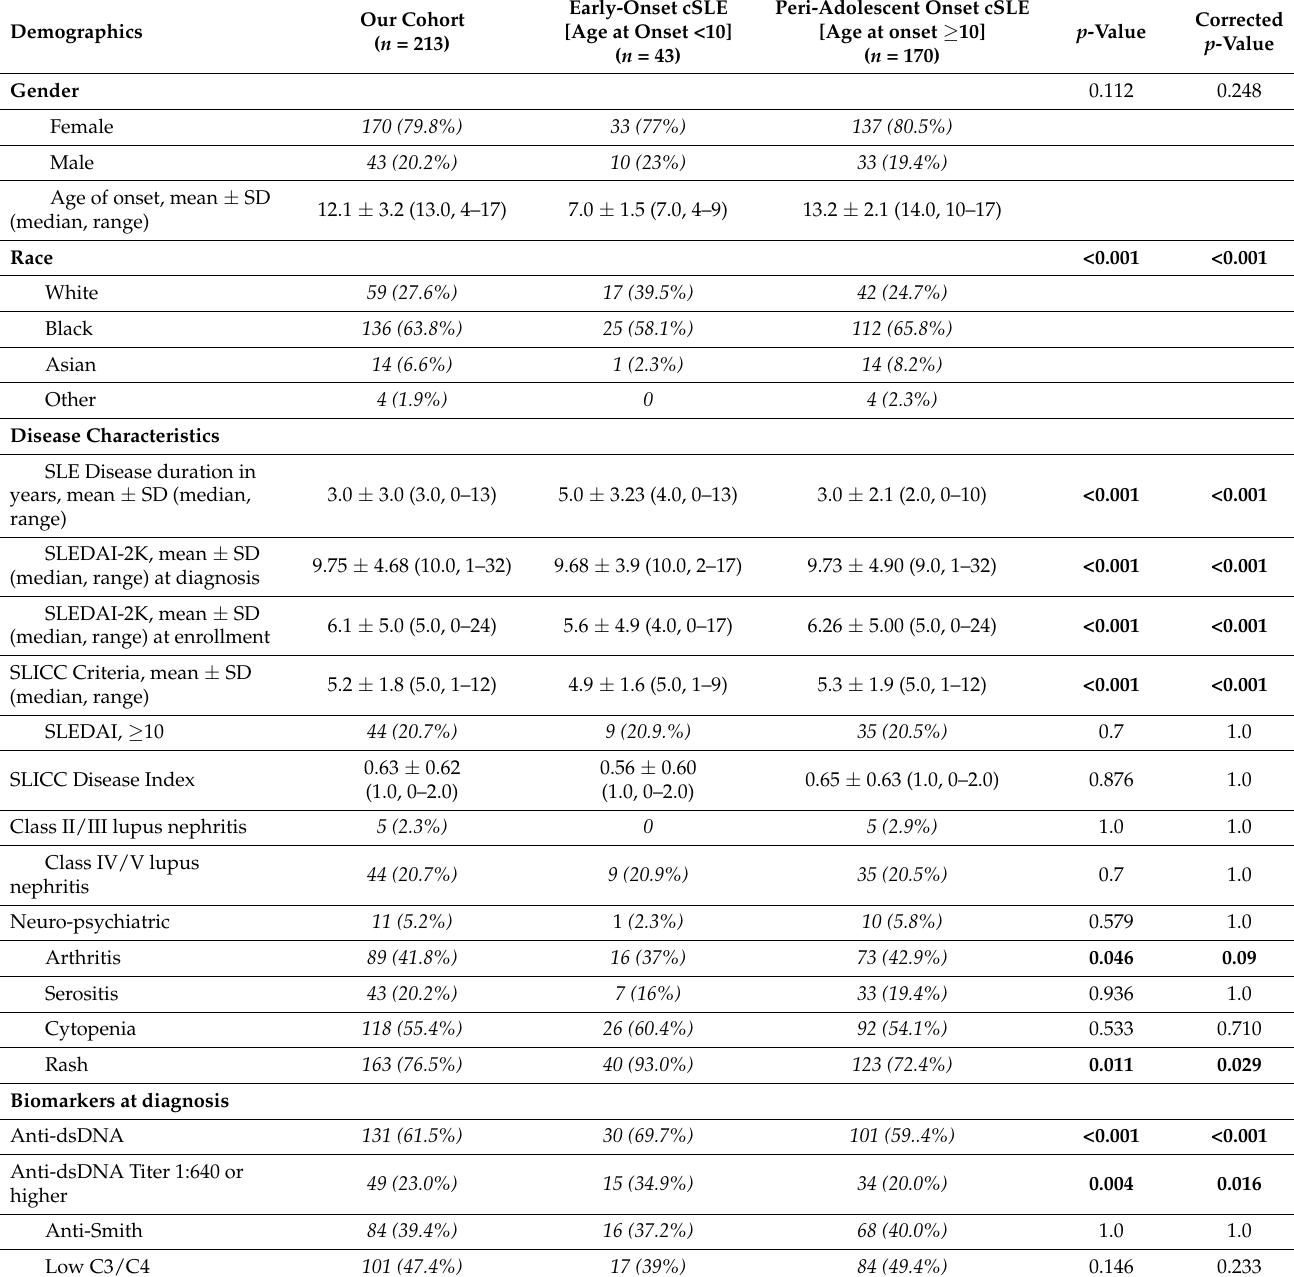
Table 1. Demographics and Clinical Features of Enrolled Subjects with Childhood-onset Systemic Lupus Erythematosus Stratified by Age 1